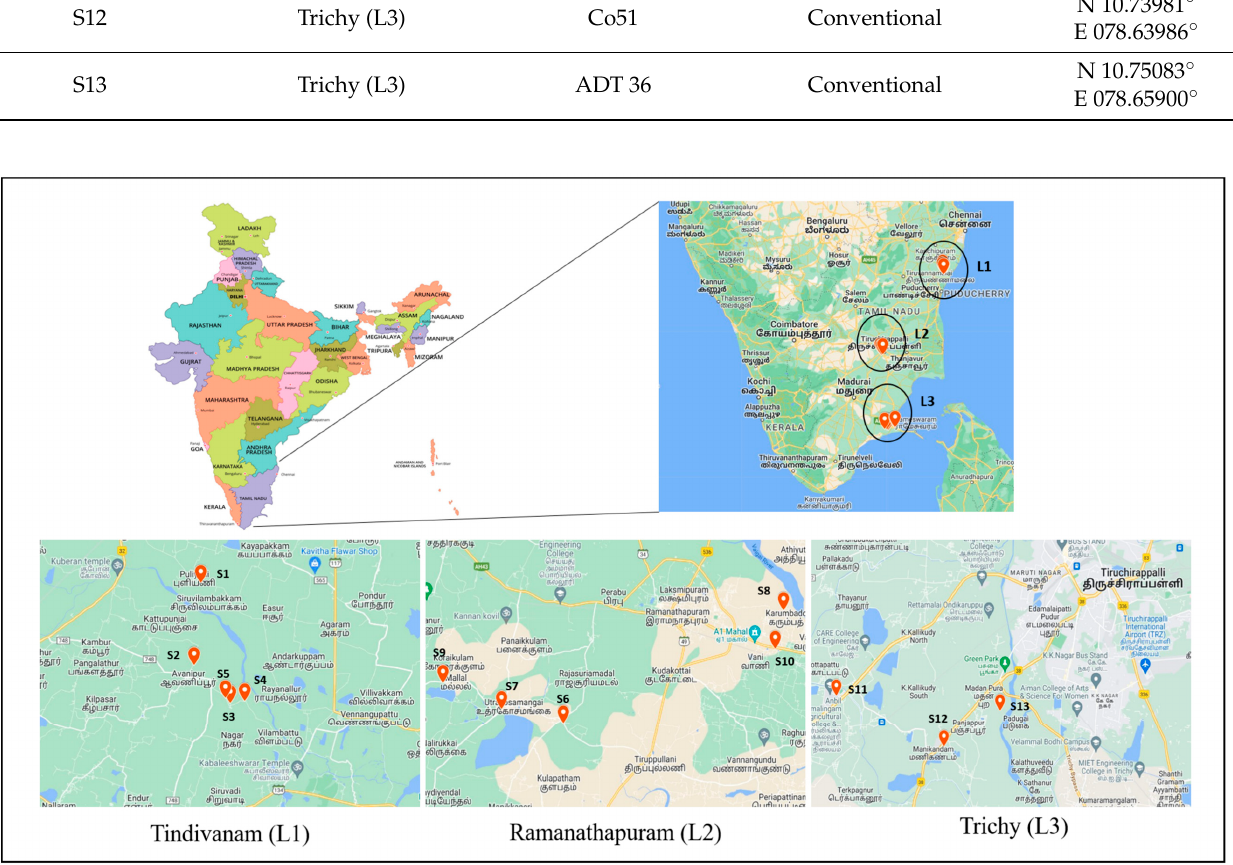
Figure 1. Map showing the sampling point of soil samples from three different districts of Tamil Nadu, India.